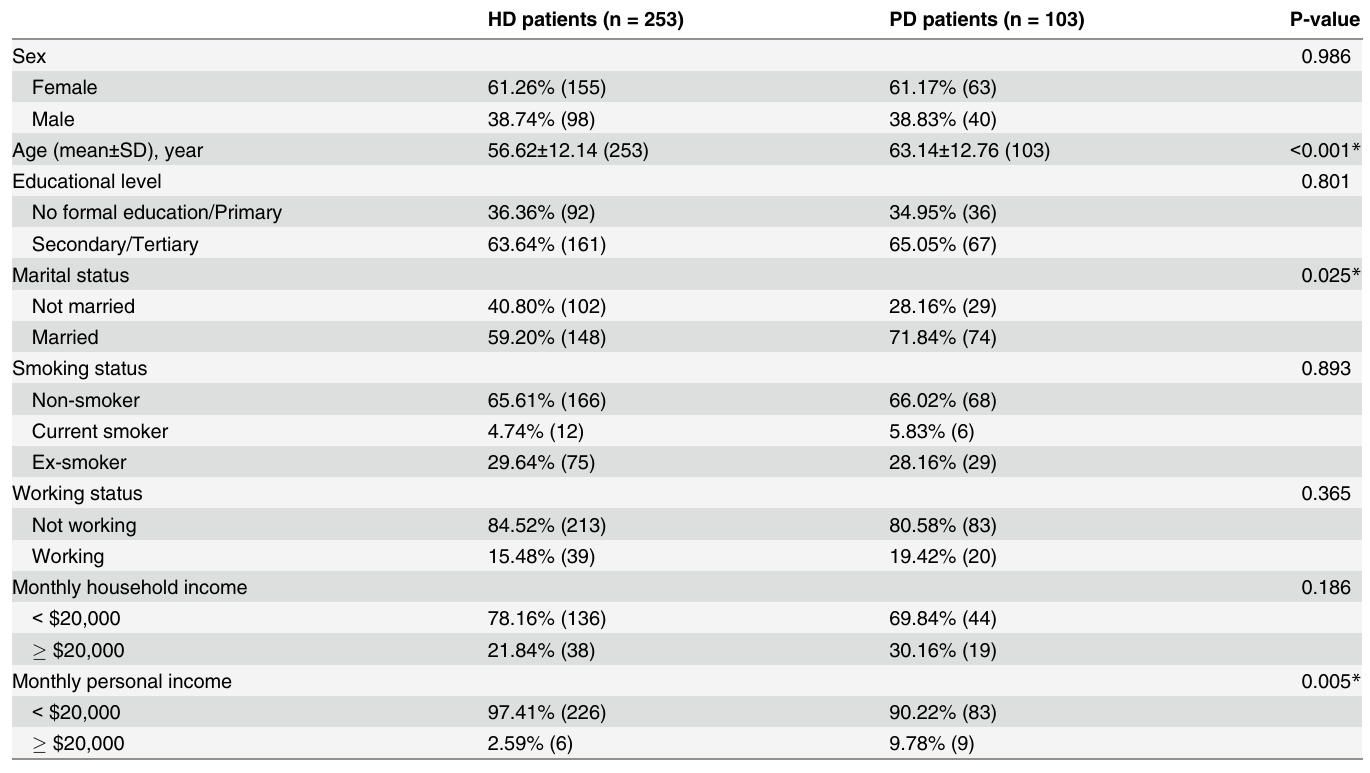
Table 2. Socio-demographic characteristics of HD and PD